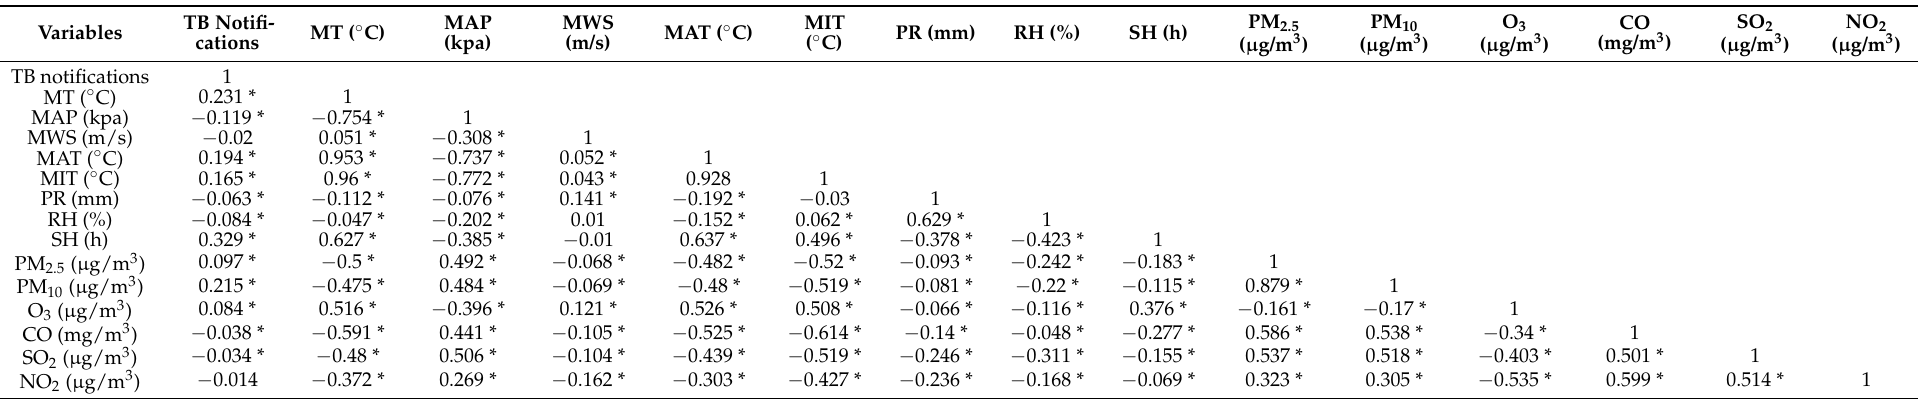
Table 3. Spearman’s correlation coefficient matrix of daily TB notifications with meteorological factors and air pollutants in the same